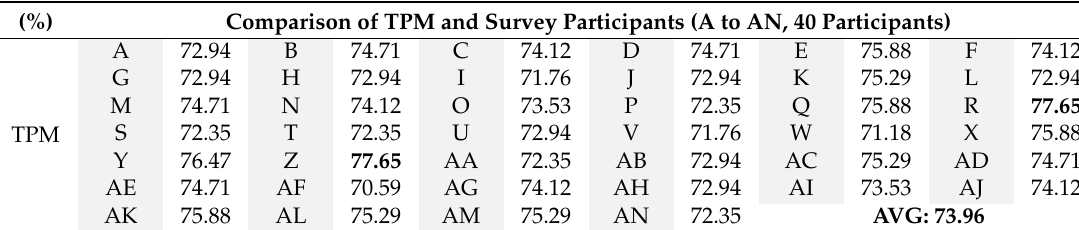
Table 3. Emotion match rate.